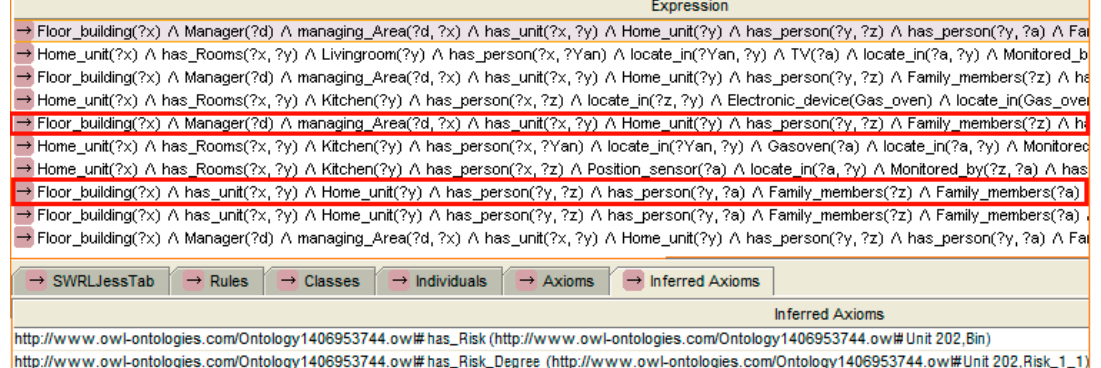
Figure 19. The reasoning process of activity “cooking”’.